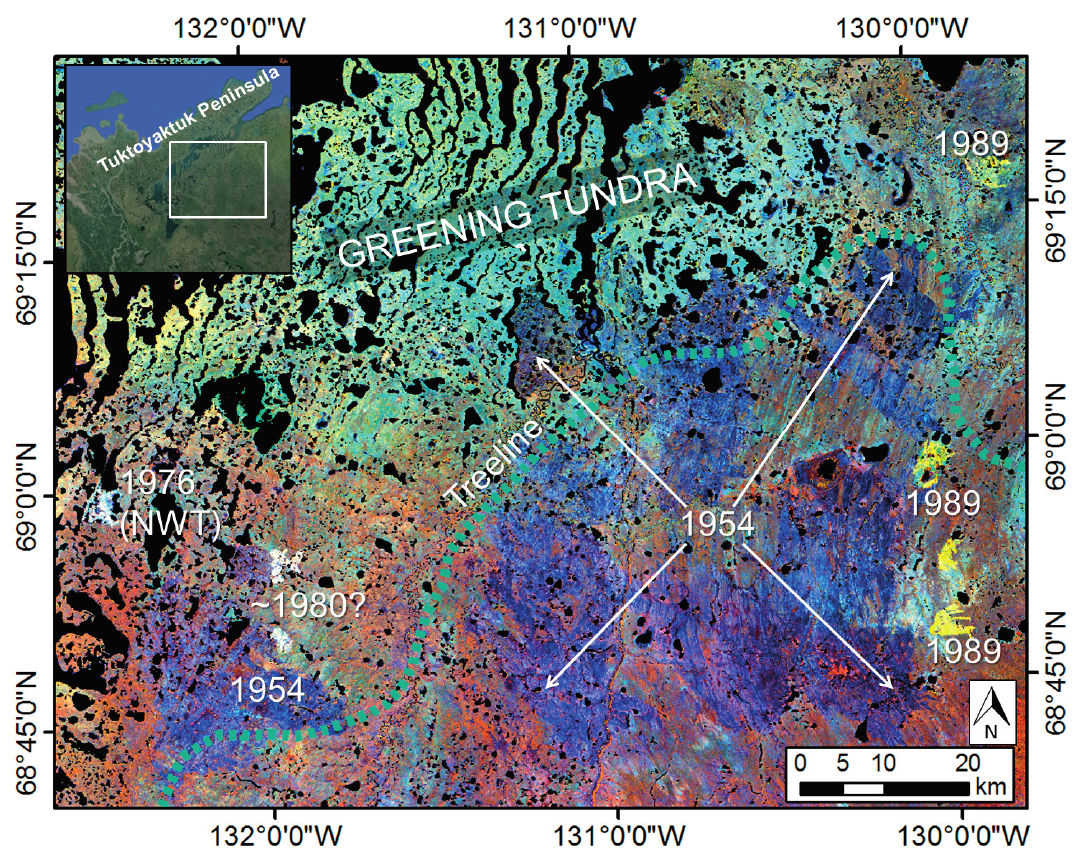
Figure 7. Area along the treeline in study region 1 containing large regenerating fire complexes, which burned in 1954 (dark blue color). Also observable are smaller, more recently regenerating burns (light and yellow colors) with year of burning indicated and greening tundra vegetation (teal color). The 1976 tundra burn is included in the NWT fire history survey. The treeline was digitized from Timoney et al. [22] and represents the 1:1 tree:upland tundra cover